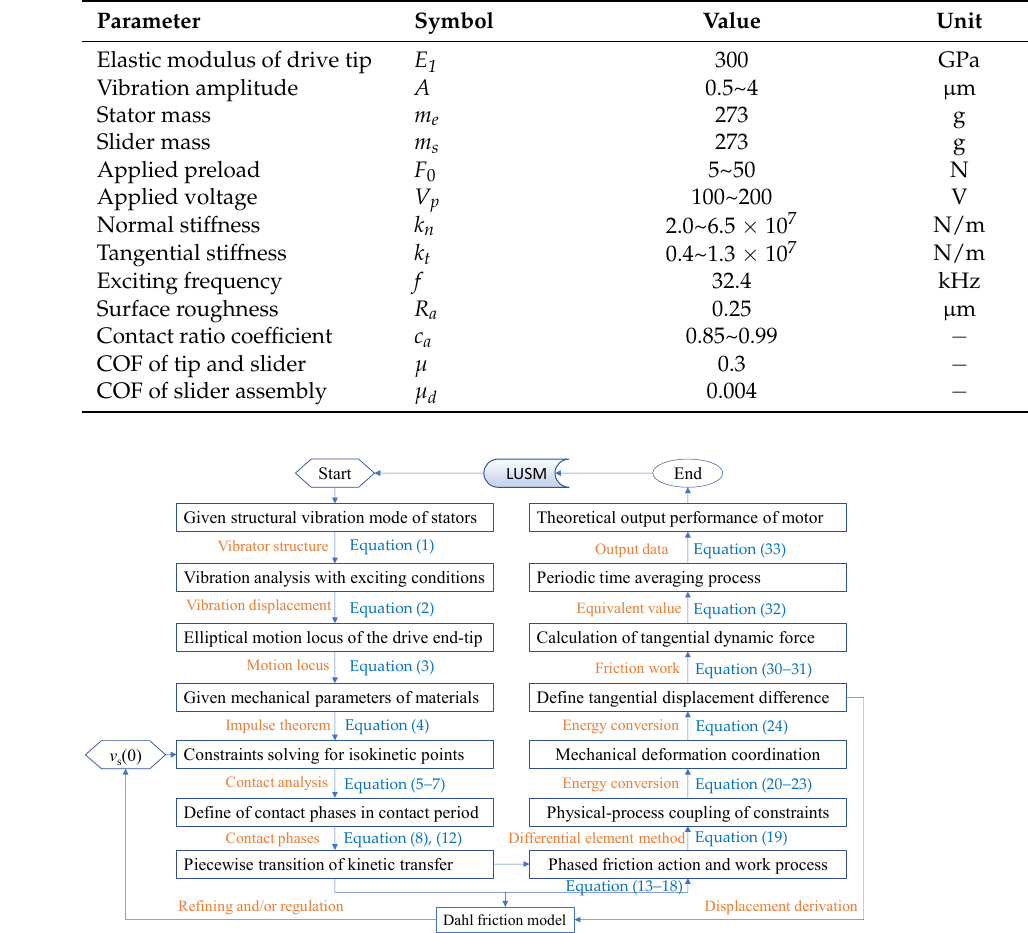
Table 2. Simulation parameters for friction-driving process of the ultrasonic motor.